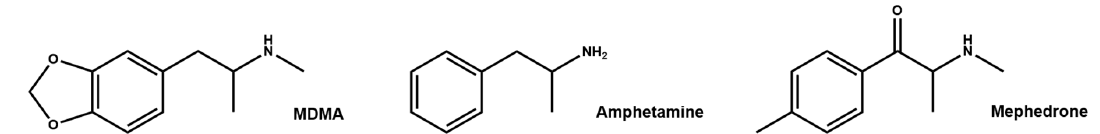
Figure 1. Chemical formulas of the psychostimulants 3,4-methylenedioxymethamphetamine (MDMA), amphetamine, and mephedrone.